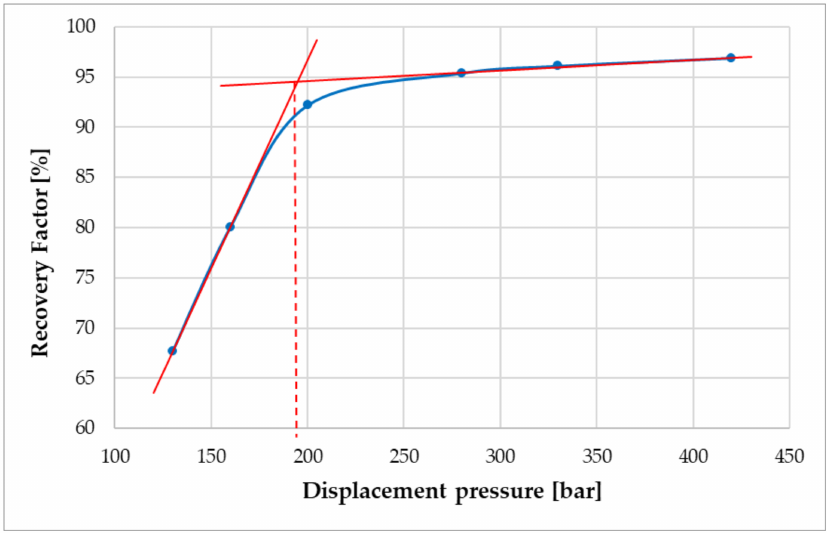
Figure 7. Slim tube recovery factors for CO 2 plotted against pressure—MMP